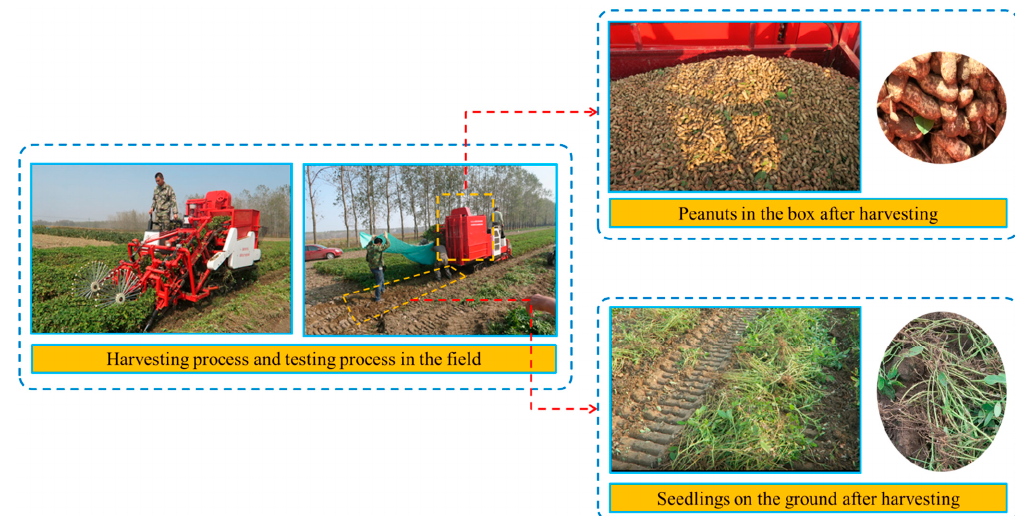
Figure 13. Validation tests in the field.